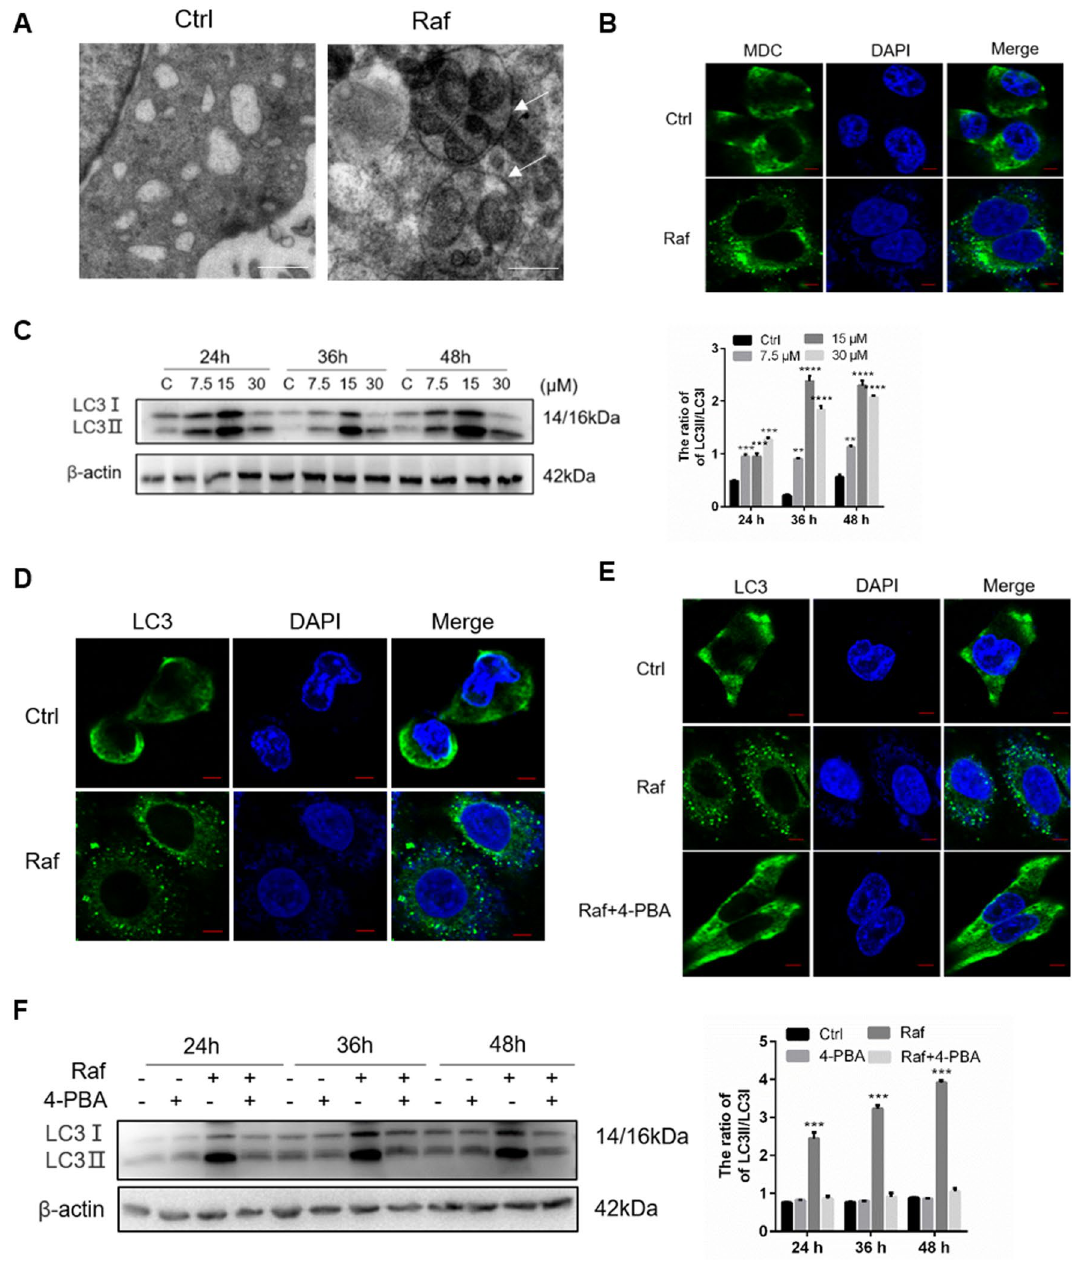
( B ) Cells were stained by MDC and observed by confocal microscopy. Scale bar, 10 μm. ( C,D ) A549 cells were treated with rafoxanide, cell lysates were obtained, and LC3 conversion was determined by western blotting. The LC3-II/LC3-I ratio was analyzed with ImageJ based on the band intensities. The formation of endogenous LC3 puncta was analyzed by fluorescence microscopy. Scale bar, 10 μm. ( E,F ) A549 cells were pretreated with 4-PBA for 2 h, and then cells were treated with rafoxanide. Formation of LC3 puncta was analyzed by immunofluorescence. Scale bar, 10 μm. Cell lysates were obtained and LC3 conversion was determined by western blotting. * P < 0.05, ** P < 0.01, *** P < 0.001, **** P <